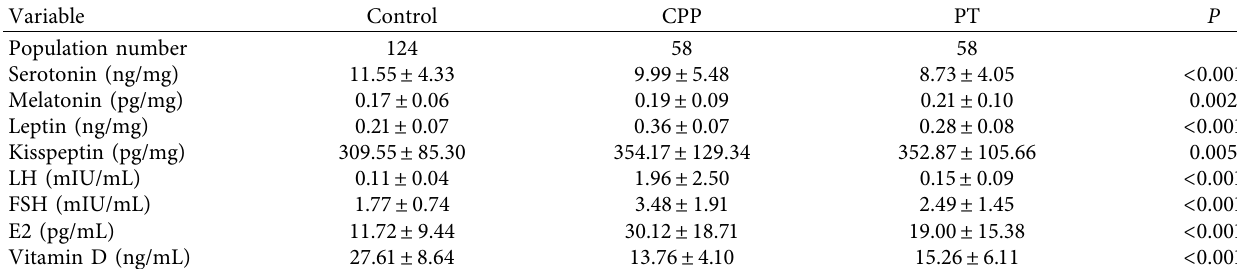
Figure 4: Logistic regression analysis of the risk factors for PT. Multivariate odds ratios and 95% confidence intervals from unconditional logistic regression models are used in the analysis. PT, premature Table 2: Hormone levels in the study population.